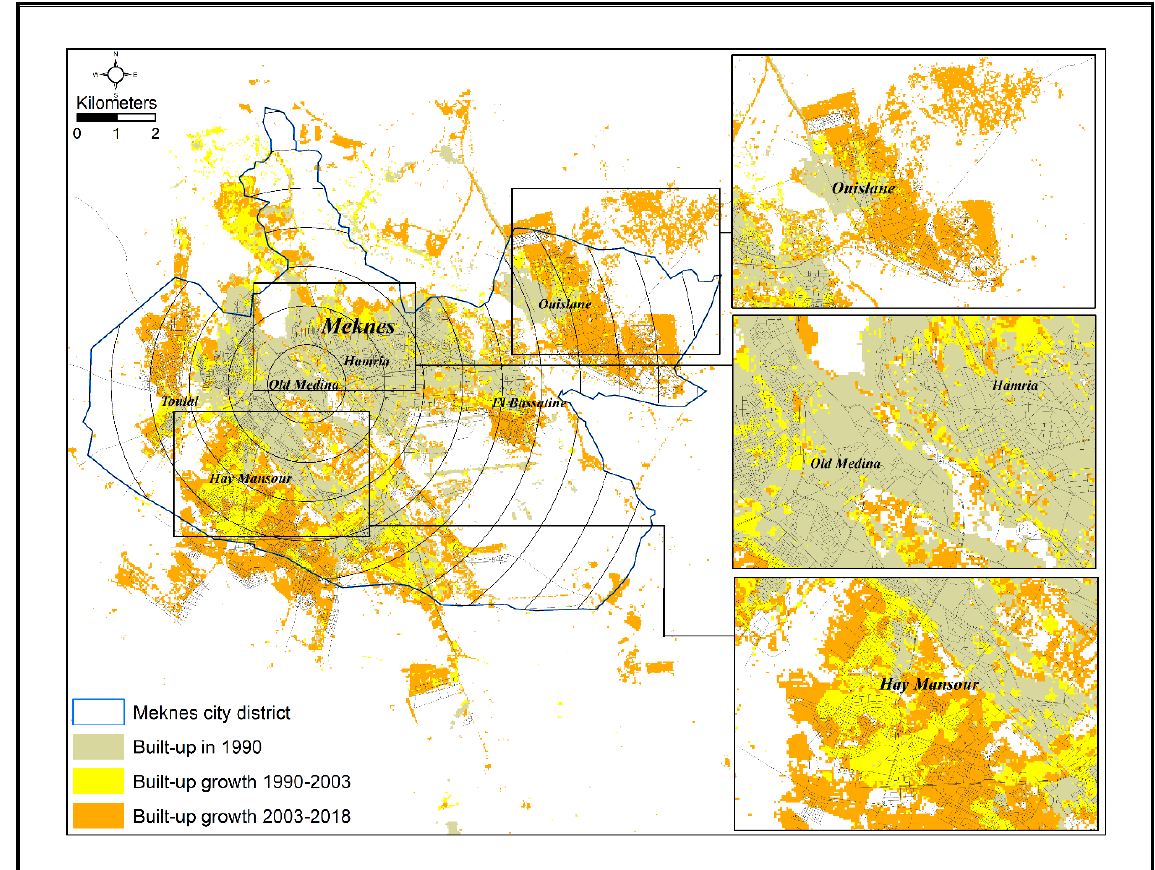
Figure 6. Observed urban expansion between 1990 and 2018 in Meknes city.